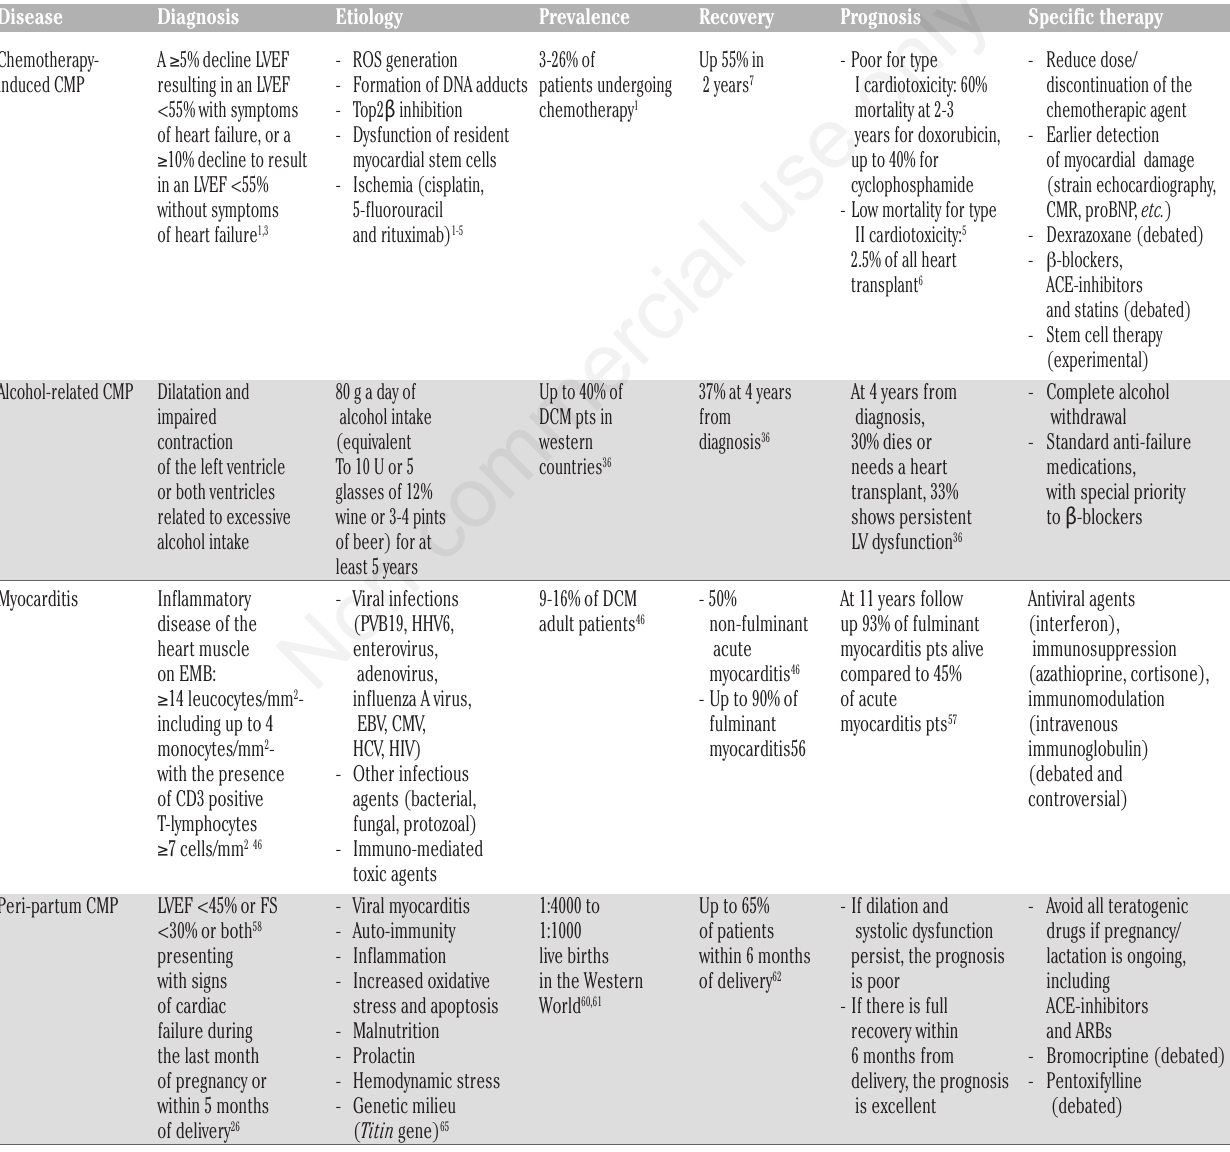
Table 2. Reversible dilated cardiomyopathies.